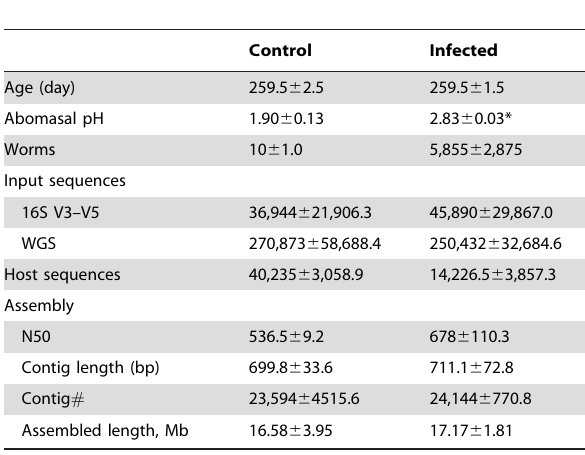
Table 1. Abomasal pH and worm burdens in immune cattle in response to Ostertagia ostertagi infection.